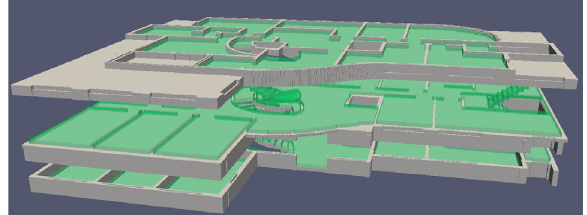
Figure 5. The (connected) navigable space in the sample building